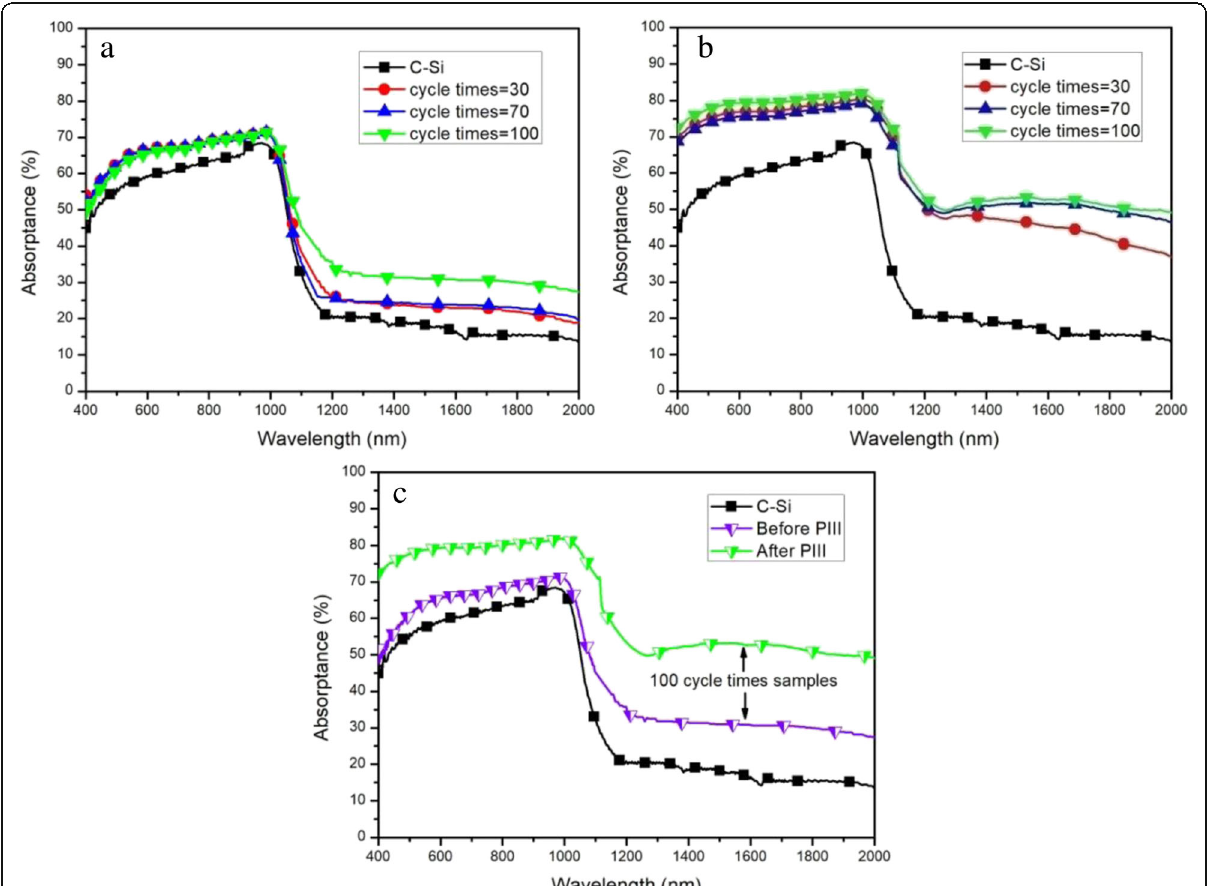
Fig. 5 Absorptance of C-Si and black silicon fabricated by different cycle times before ( a ) and after PIII ( b ) and comparison of 100 cycle samples ( c